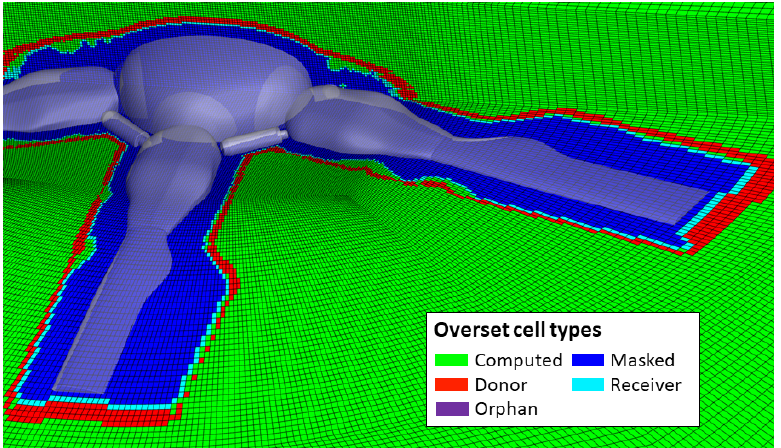
Figure 10. Slices through the applied computational mesh of the isolated rotor head showing the overset mesh cell